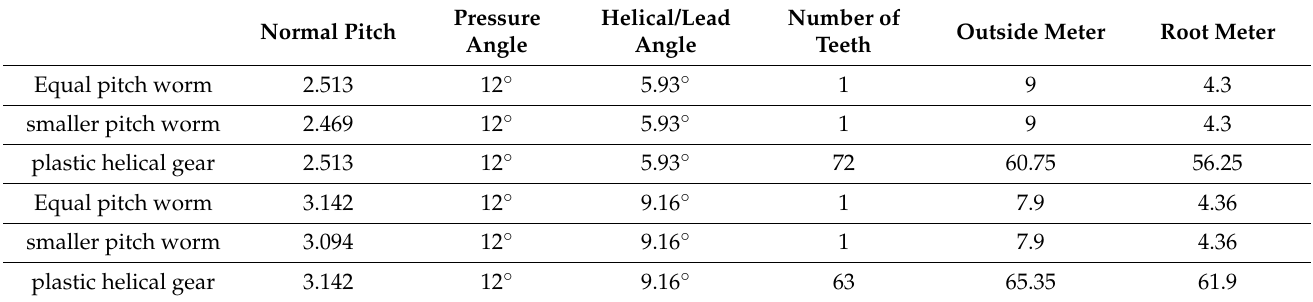
Table 4. Parameter for worm and plastic helical